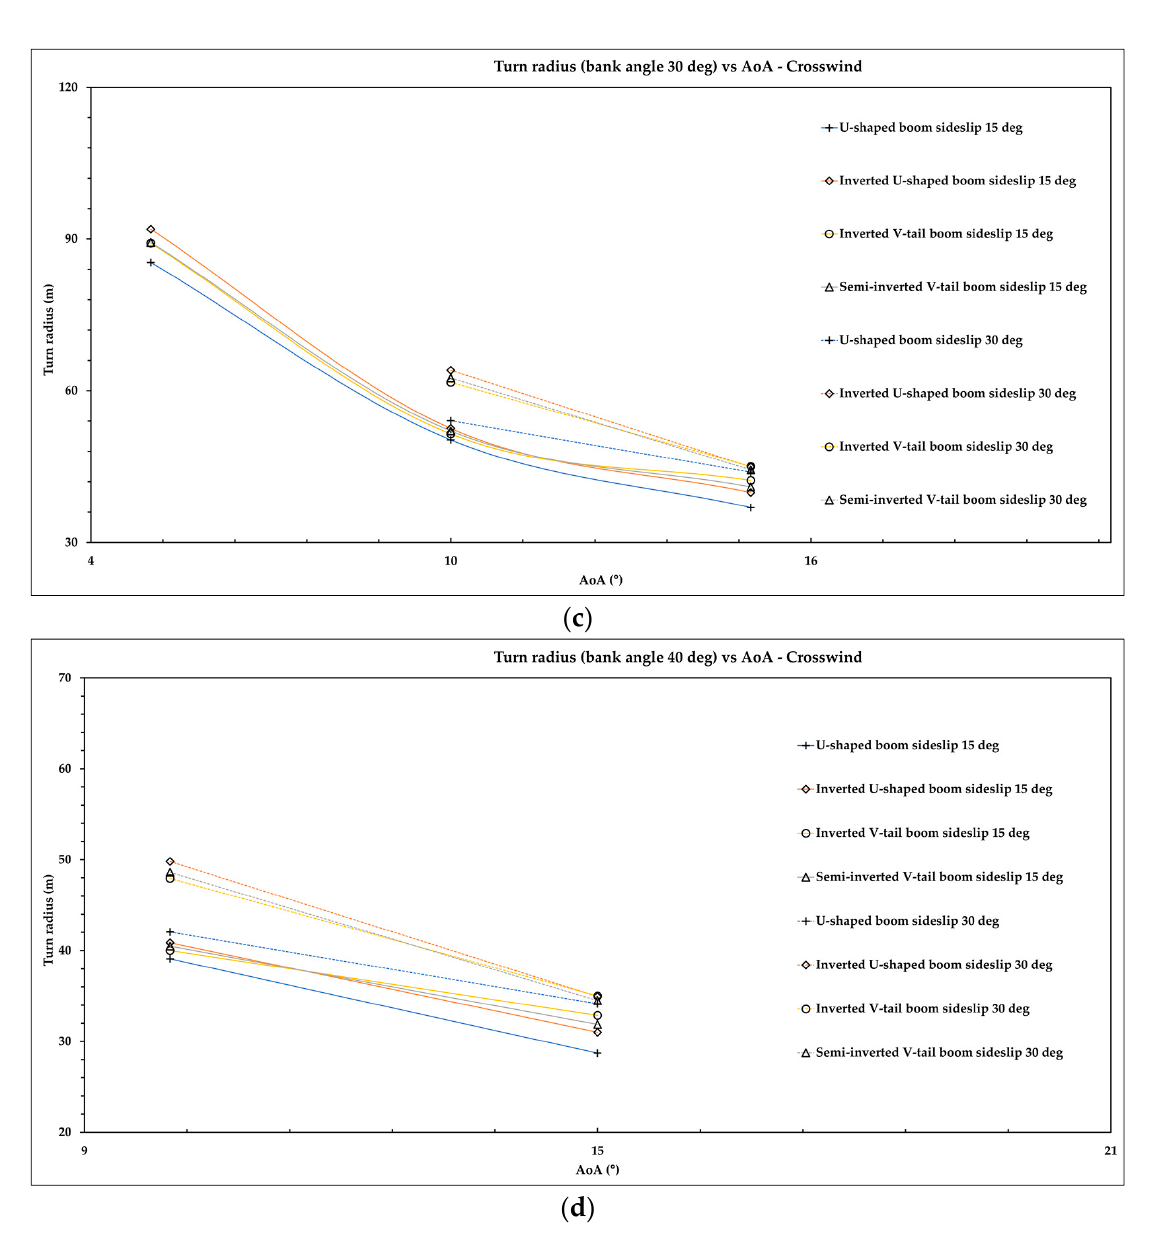
Figure 20. Maneuverability in crosswind conditions, bank angle: ( a ) 10°, ( b ) 20°,( c ) 30°, and ( d ) 40°. According to the CFD simulation results, the VTOL-Plane needed a greater than 5 ◦ angle of attack to complete the maneuver in crosswind conditions. Its purpose is to protect the plane from stalling. Figure 20 shows that each VTOL-Plane design variation had the smallest turning radius with a bank angle of 40 ◦ with AoA 15 ◦ in crosswind conditions. The 10 ◦ . The greater the sideslip angle, the greater the turning radius. Overall, the VTOL-Plane designs, which was 28.7